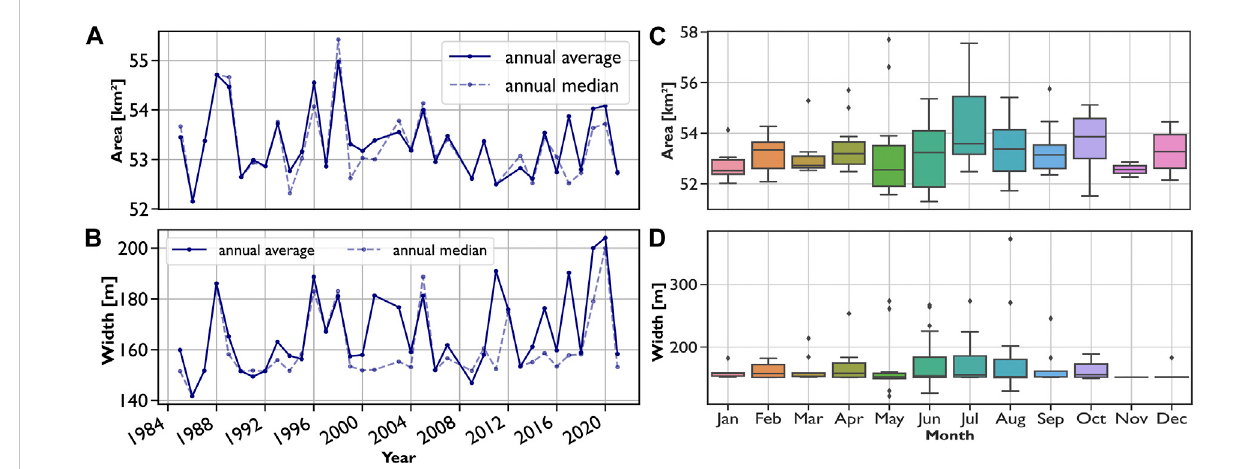
FIGURE 2 Marambaia barrier island variability (1985 – 2021): annual averages and medians of (A) total area and (B) central section width; and monthly variation of (C) total area and (D) central section width.